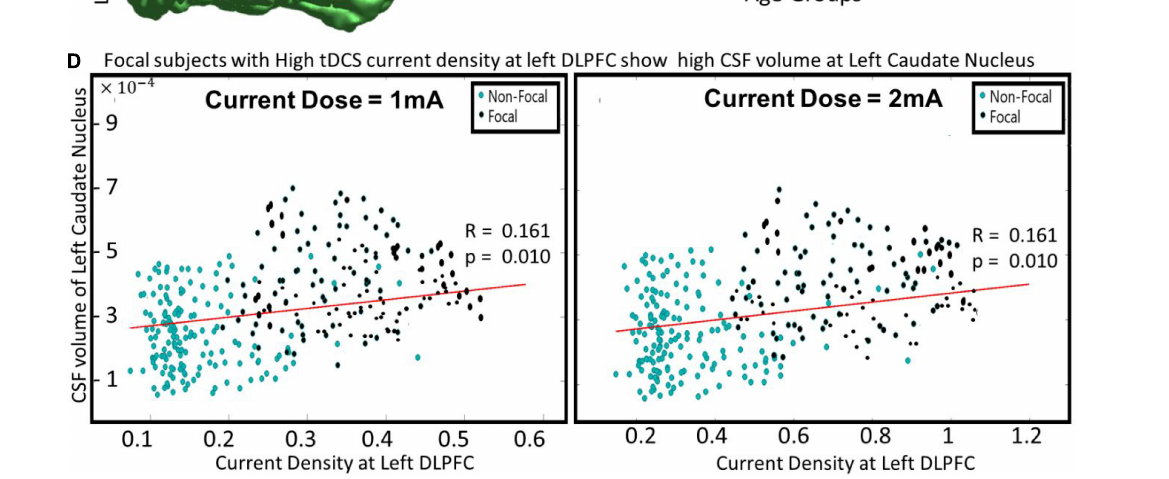
at the right caudate nucleus with the current density at the target area (left DLPFC) was insignificant for both current doses (figure not